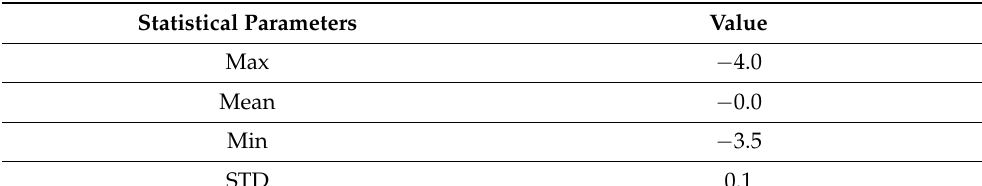
Table A2. Statistics of the Moho depth differences obtained by solving the VMM problem by using the EGM2008 and EIGEN-6C4 gravitational models. Unit: km.